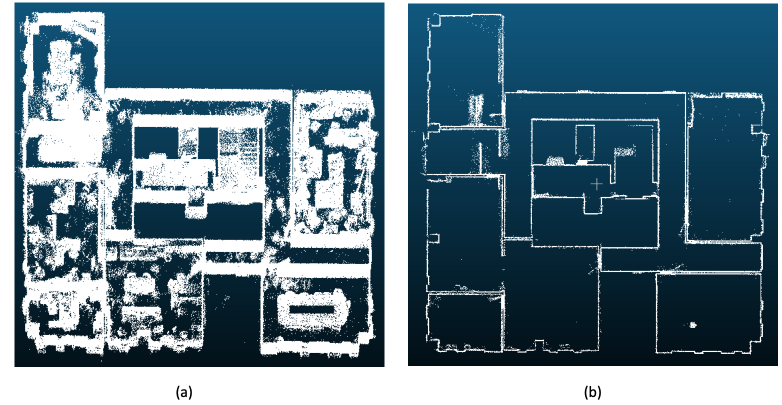
Figure 2. Result of wall proposal for seventh floor of the Robot Convergence Building at Korea University: ( a ) 3D point clouds after removing the floor and ceiling, and ( b ) 3D point clouds of wall proposal